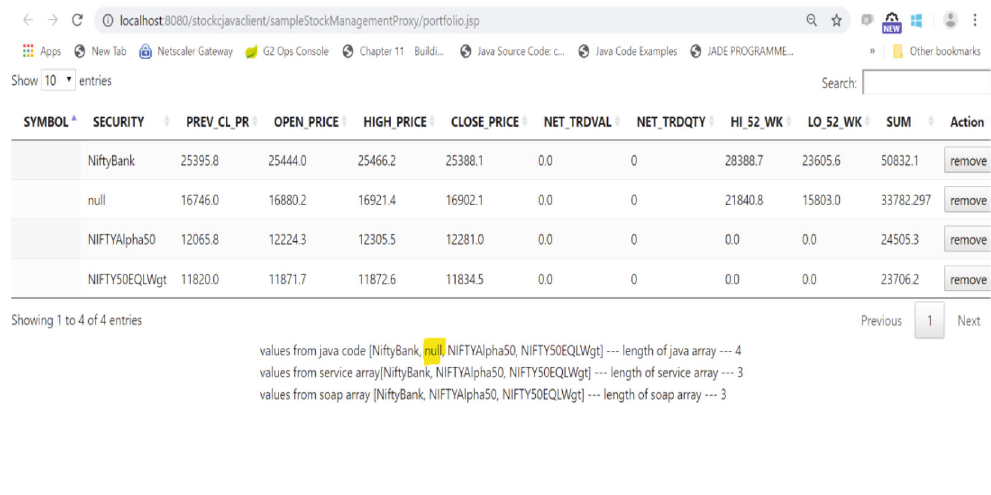
Figure 10: Array with null value in JAVA.